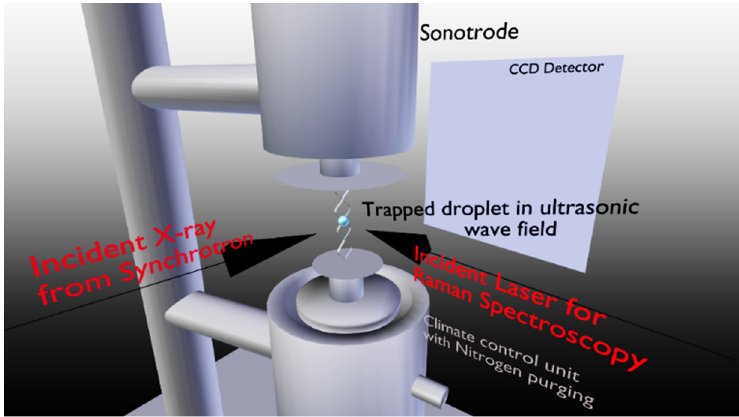
Figure 1. Schematic diagram of acoustic levitator for time-resolved Raman spectroscopy.